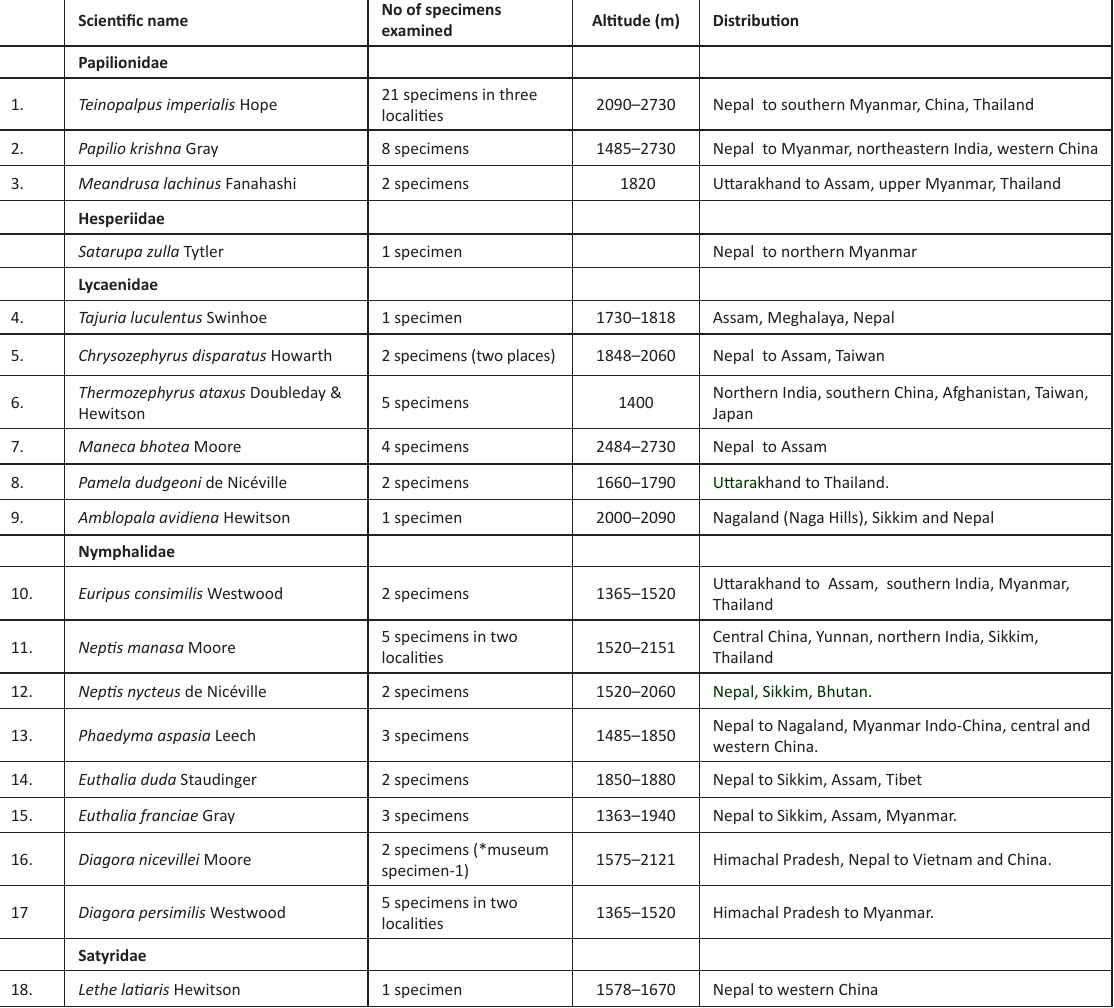
Table 1. Threatened butterfly species and altitudinal distribution across the study